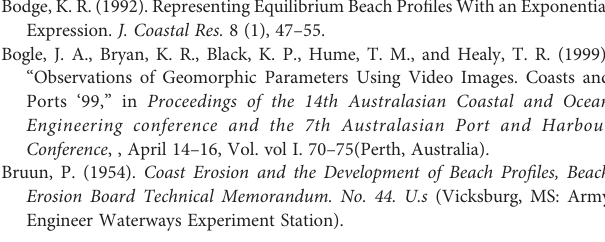
Supplementary Figure 1 | Study site. (A) Location of Tairua, New Zealand North Island (B) detail of Tairua Beach. Pressure sensor (S4_N) location used for SWAN model validation (Montaño et al., 2020). Supplementary Figure 2 | Input conditions. (A) Signi fi cant wave height (B) mean wave period (C) wave direction (Montaño et al., 2020). Supplementary Figure 3 | Information related to beach pro fi le observation data (https://coastalhub.science/data). Supplementary Figure 4 | (A) Instrumented sled used during the experiment at Tairua Beach. (B) Time averaged video image of Tairua Beach during the experiment. Measurements were taken in the cross-shore transect as indicated by the black line (van Maanen et al., 2008). Supplementary Figure 5 | Measured (A) wave height H rms and offshore zero crossing (B) wave period T m 02 , and (C) tidal elevation during the experiment (van Maanen et al., 2008).